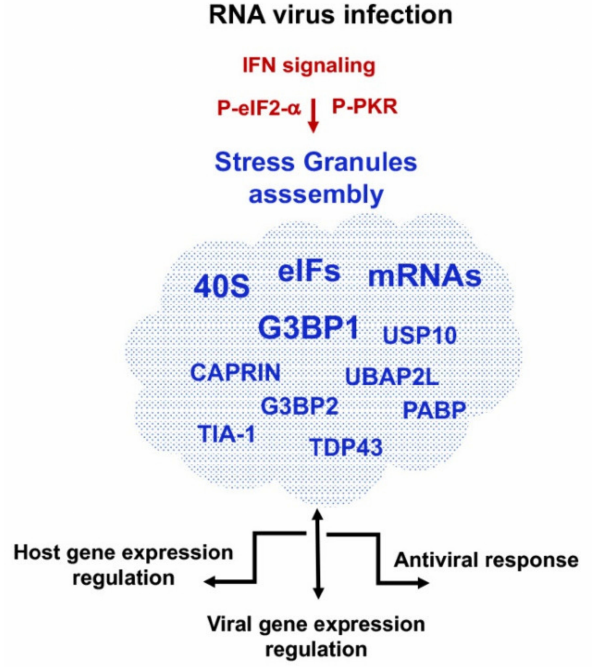
Figure 3. Pathways leading to the assembly of stress granules (SGs) in RNA virus infected cells and outcome in gene expression regulation. Early infection events trigger the interferon (IFN) signaling, concomitant to protein kinase R (PKR) activation via dsRNA and eIF2 α phosphorylation, leading to SGs assembly, generating a cascade of pathways that impact on host gene expression, viral gene regulation, and antiviral response. Blue letters denote main components of